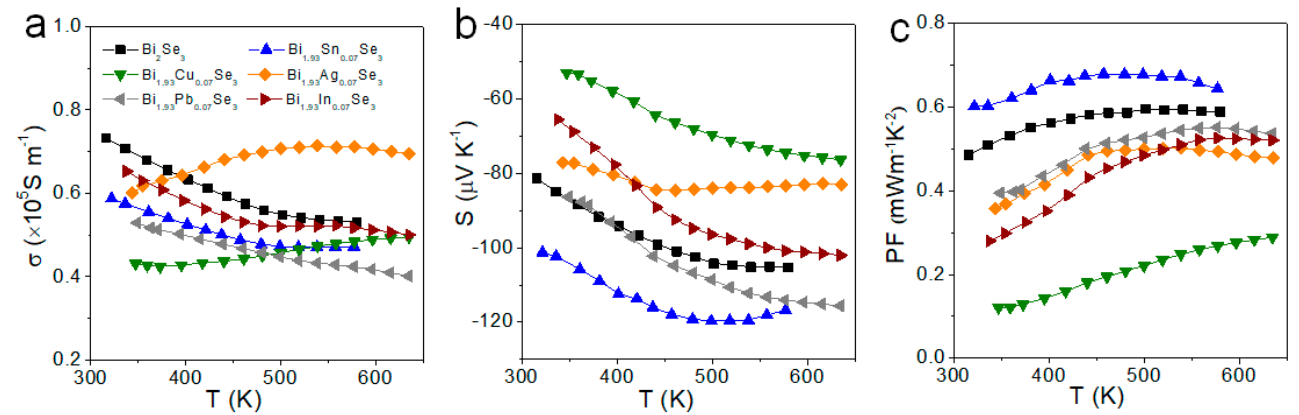
Figure 3. TE properties of Bi 2 − x M x Se 3 (M = Sn, Cu, Ag, Pb, In) samples measured perpendicular to the press direction: ( a ) electrical conductivity, σ ; ( b ) Seebeck coefficient, S ; ( c ) power factor, PF .